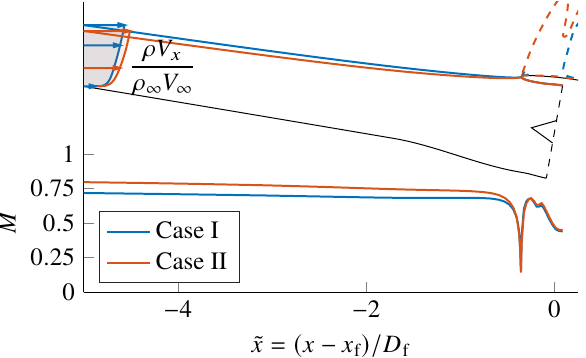
Figure 9. Stagnation streamline at centre plane and its variations of Mach number M . The M = 1 contours are in dashed lines and the profiles of mass flux ( ρ V x ) / ( ρ ∞ V ∞ ) at ˜ x =